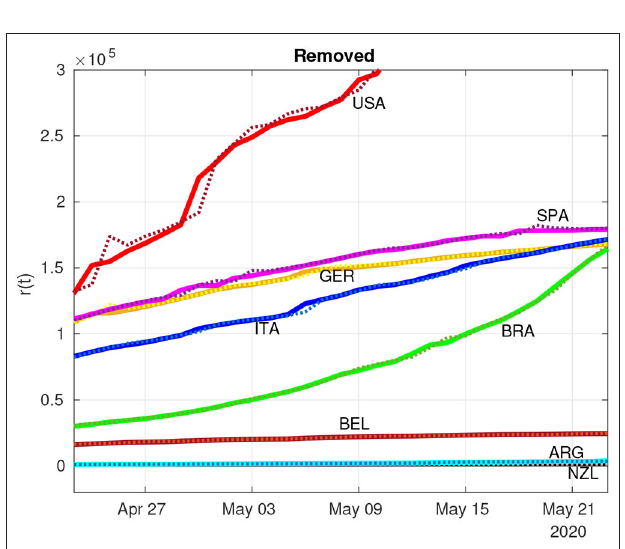
FIGURE 5 | Estimation (dotted lines) of removed individuals (continuous lines) using the RLS technique.